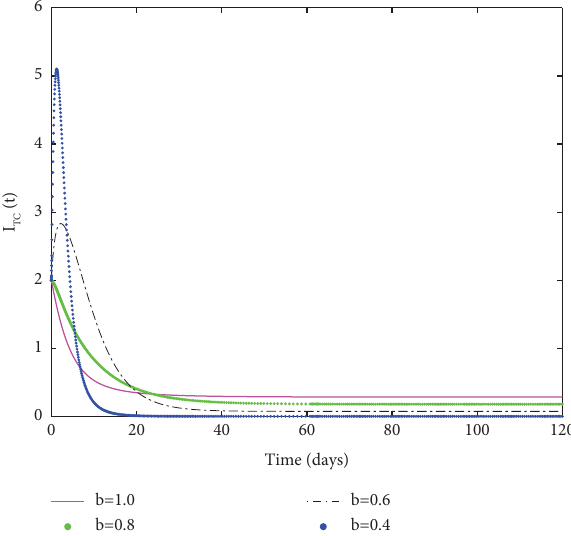
Figure 6: Behaviour of the COVID-19 symptomatic individuals at diferent values of b .